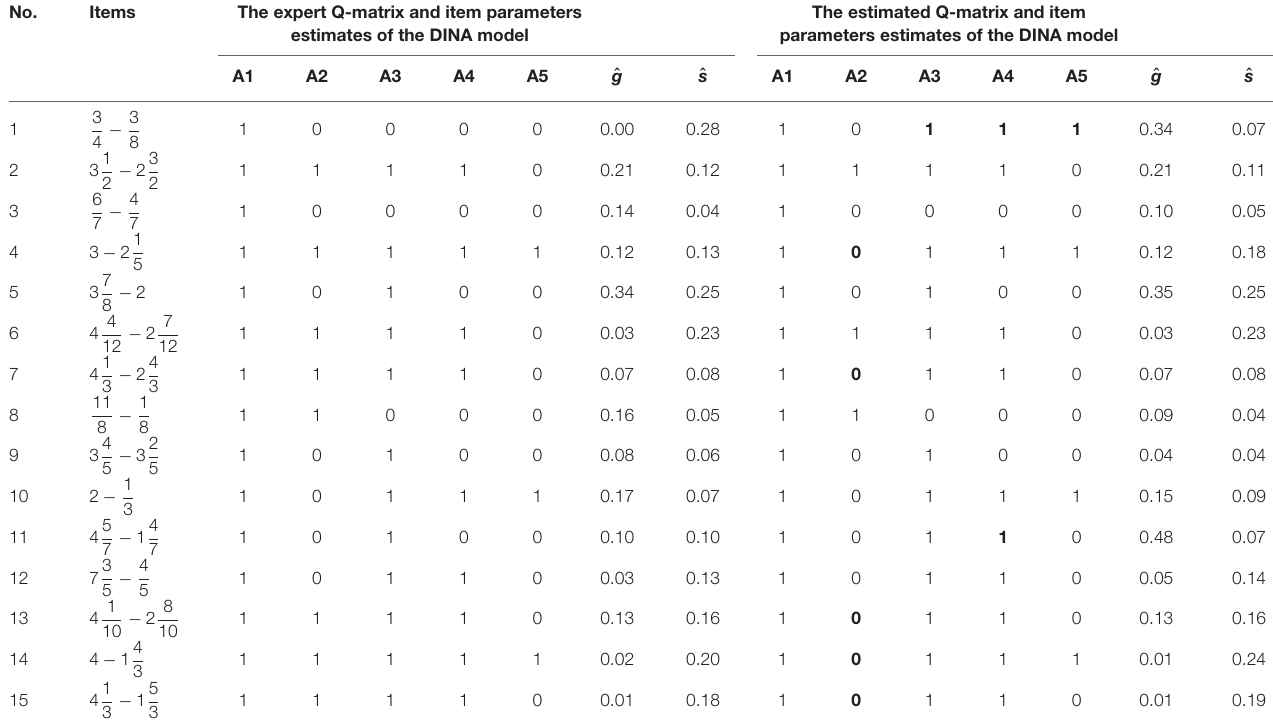
TABLE 6 | The expert and estimated Q-matrix and item parameters estimates of the DINA model for the fractional subtraction data. No. Items The expert Q-matrix and item parameters estimates of the DINA model